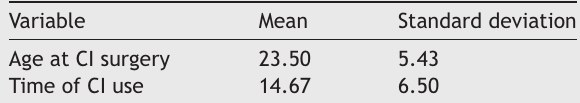
Mean age (months) at surgery and time of CI use.